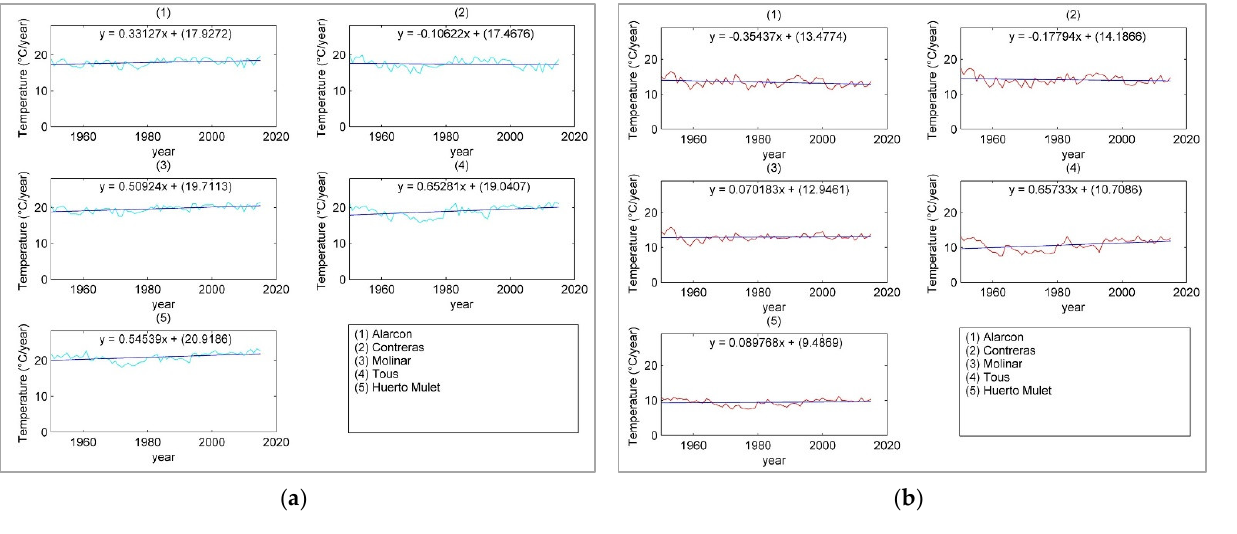
◦ C) and ( b ) tempera-